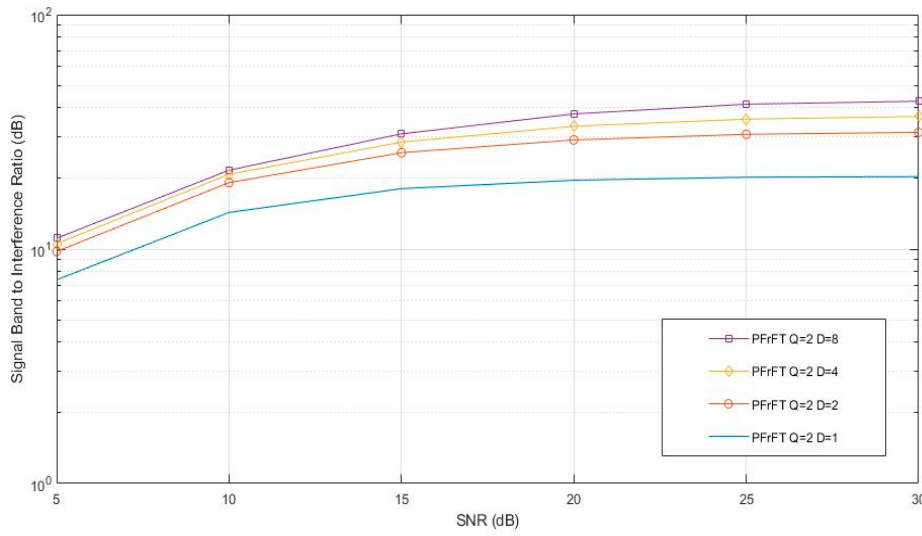
df ) of PFFT ( a ) and PFrFT ( b ).